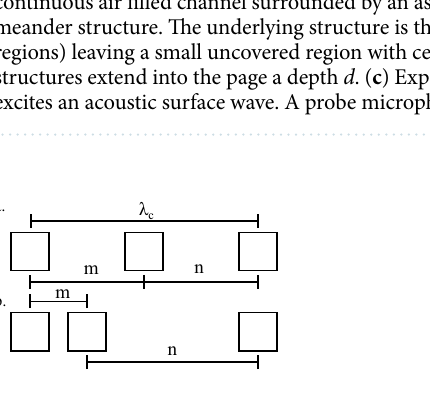
Figure 2. Apparent spacing of cavities in the partly covered meander structure. Here (cid:31) c is the path length along the meander between neighbouring unit cells and m and n is the distance between neighbouring cavities with m + n = (cid:31) c . ( a ) The uncovered section is aligned with the centre of the meander structure ( s = 0 ). In this case m = n . ( b ) The uncovered section unaligned with the centre of the meander structure ( s = 0